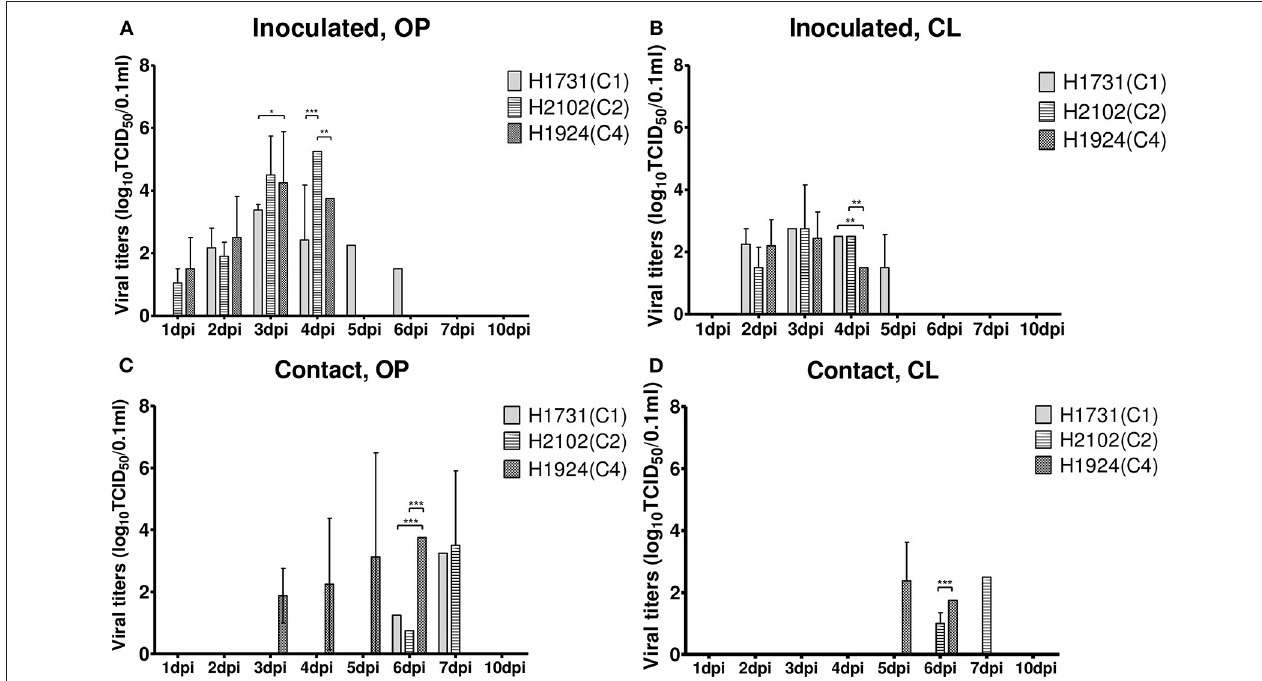
FIGURE 2 | Shedding of H1731, H1924, and H2102 viruses in SPF chickens. Virus was isolated from swab samples collected from (A,B) chickens intranasally inoculated with 10 6 EID 50 /0.1ml of virus and (C,D) from chickens cohoused with inoculated chickens. Viral titer was measured in DF-1 cells and shown as the mean ± standard deviation. * p < 0.05, ** p < 0.01, *** p < 0.001. OP, oropharyngeal; CL, cloacal; SPF, specific pathogen-free; TICD 50 , median tissue culture infectious dose.